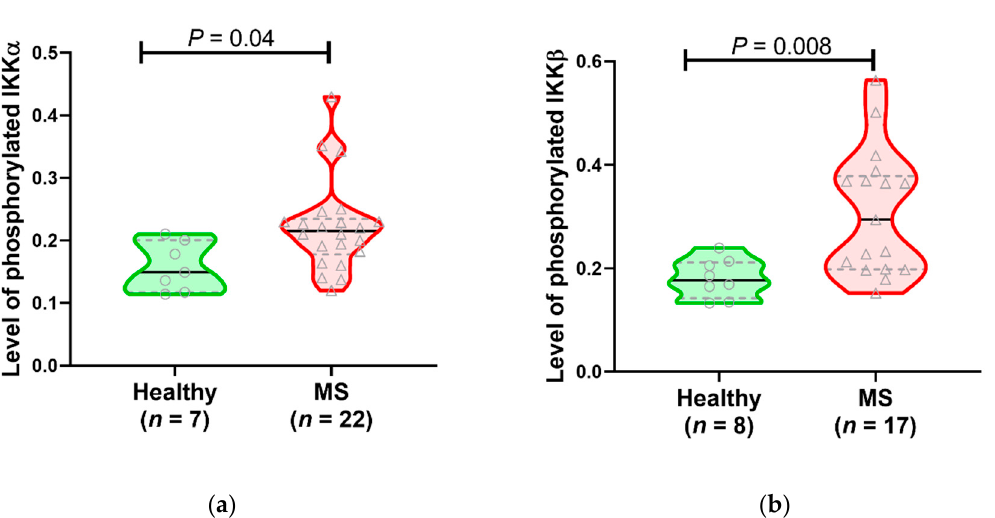
Figure 4. Levels of phosphorylated IKK α and IKK β are elevated in MS patients compared to healthy subjects. ( a ) Levels of phosphorylated IKK α are increased in some (but not all) MS patients. ( b ) Elevated levels of phosphorylated IKK β are present in MS patients compared to healthy controls. In these violin plots, a solid line indicates the median, and dotted lines show the interquartile range. Analyzed by two-tailed Mann–Whitney U test.